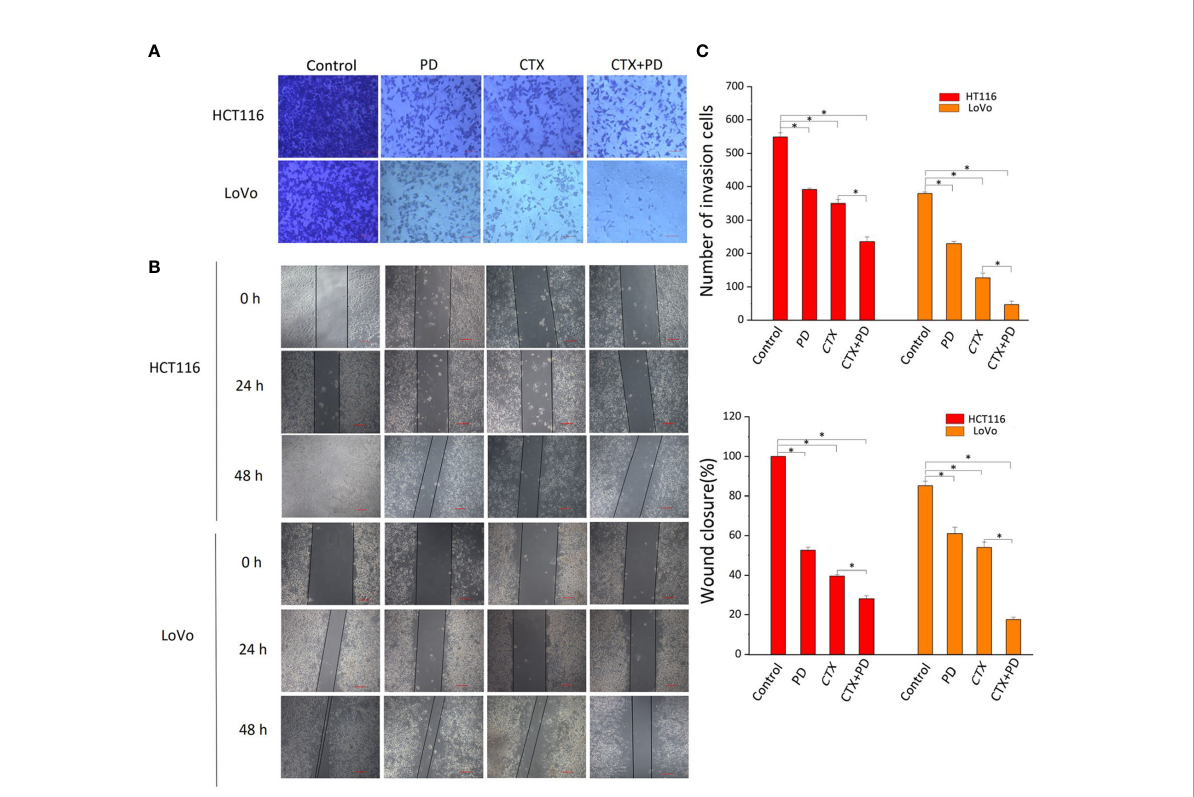
FIGURE 5 Results of Transwell and scratch wound-healing assays. (A) Invasion of HCT116 and LoVo cells were both measured by Transwell assay. The top row shows various drug treatments. Scale bars, 100 m m. (B) Migration of HCT116 and LoVo cells were both measured by scratch wound-healing assay. The top row shows various drug treatments. The left column shows the type of cells and time of measurement. (C) Bar diagrams of Transwell (C1) and scratch wound-healing (C2) assays. Columns show the mean ± S.D. One-way ANOVA was conducted to analyze P values between groups. All groups are compared with the ‘ Control ’ group, and the ‘ CTX ’ group is compared with the ‘ CTX+PD ’ group. * P < 0.05 represents a signi fi cant